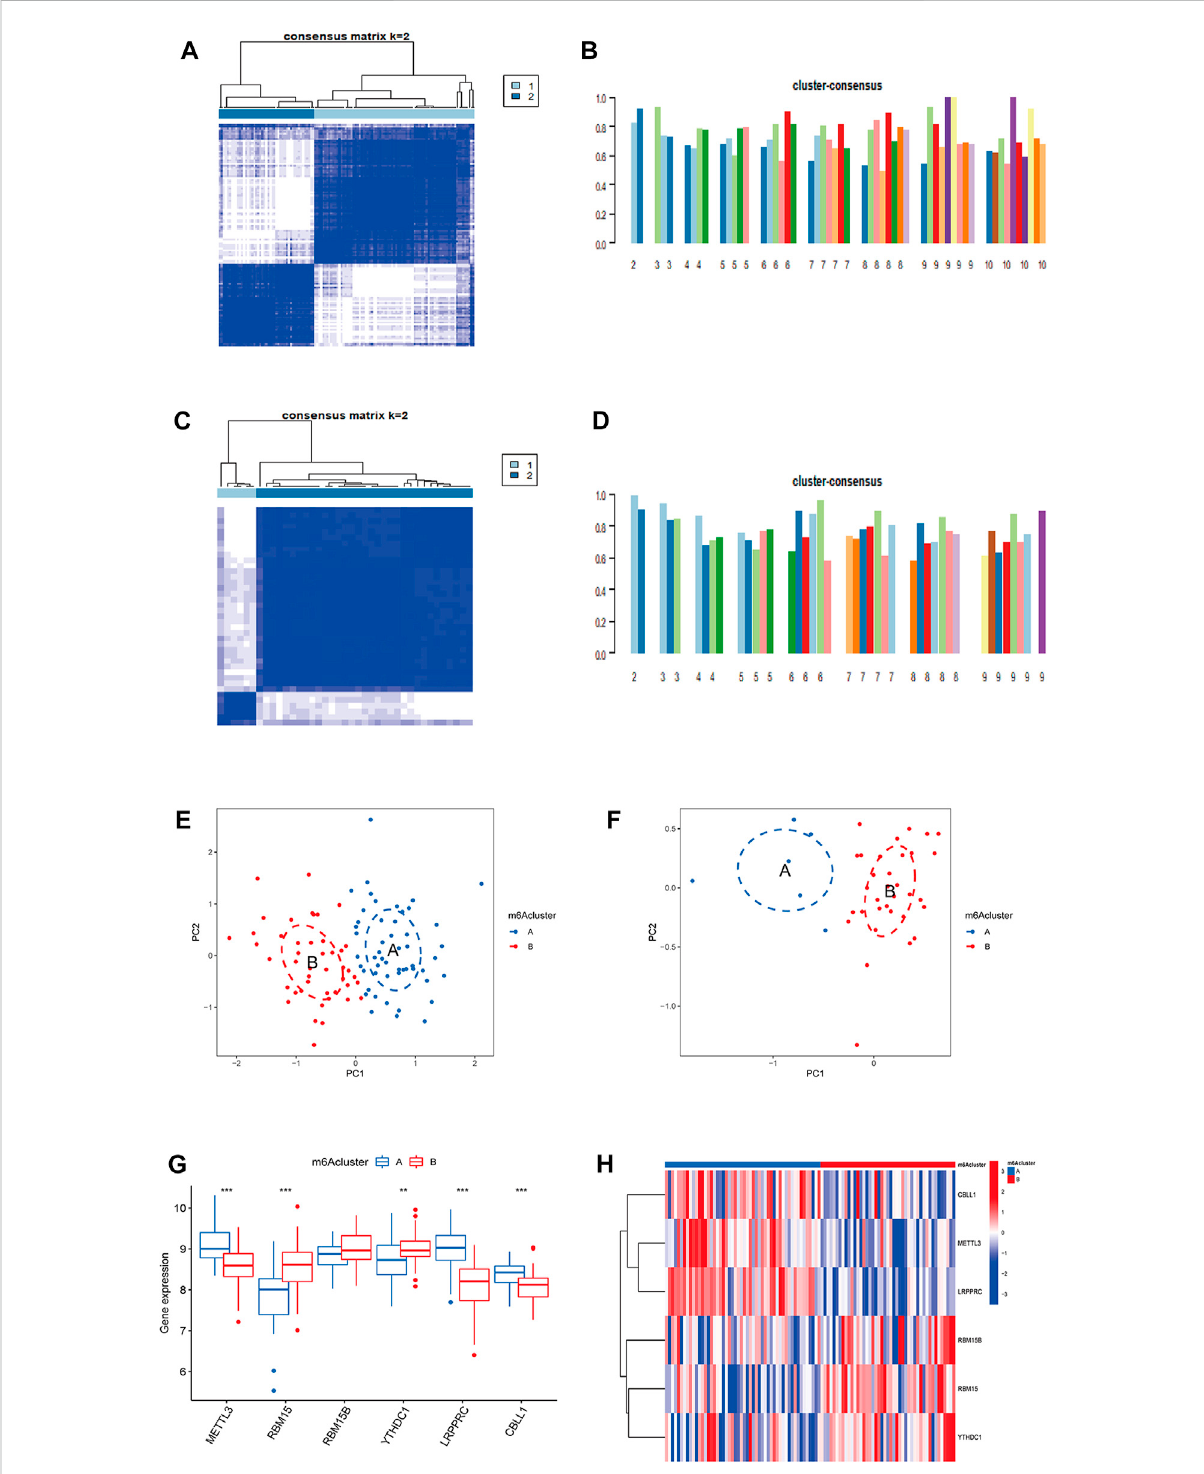
FIGURE 3 Molecular subgroups based on clustering analysis of m6A regulators. (A) Heatmap of 2 clusters (k = 2) based on m6A regulators from the GSE16129 dataset. (B) Consistency scores of all the text clusters (k = 2 – 10). (C) Heatmap of 2 clusters (k = 2) based on m6A regulators from the GSE30119dataset. (D) Consistencyscoresofallthevalidationclusters(k=2 – 9). (E) PCAanalysisofthe2clustersinthetextgroup. (F) PCAanalysisof the2clustersinthevalidationgroup. (G) Boxdiagramofdifferentialexpressionof6signi fi cantm6Aregulatorsintwom6Aclustersfromthetext group. (H) Heatmap of differential expression of 6 signi fi cant m6A regulators in two m6A clusters from the text